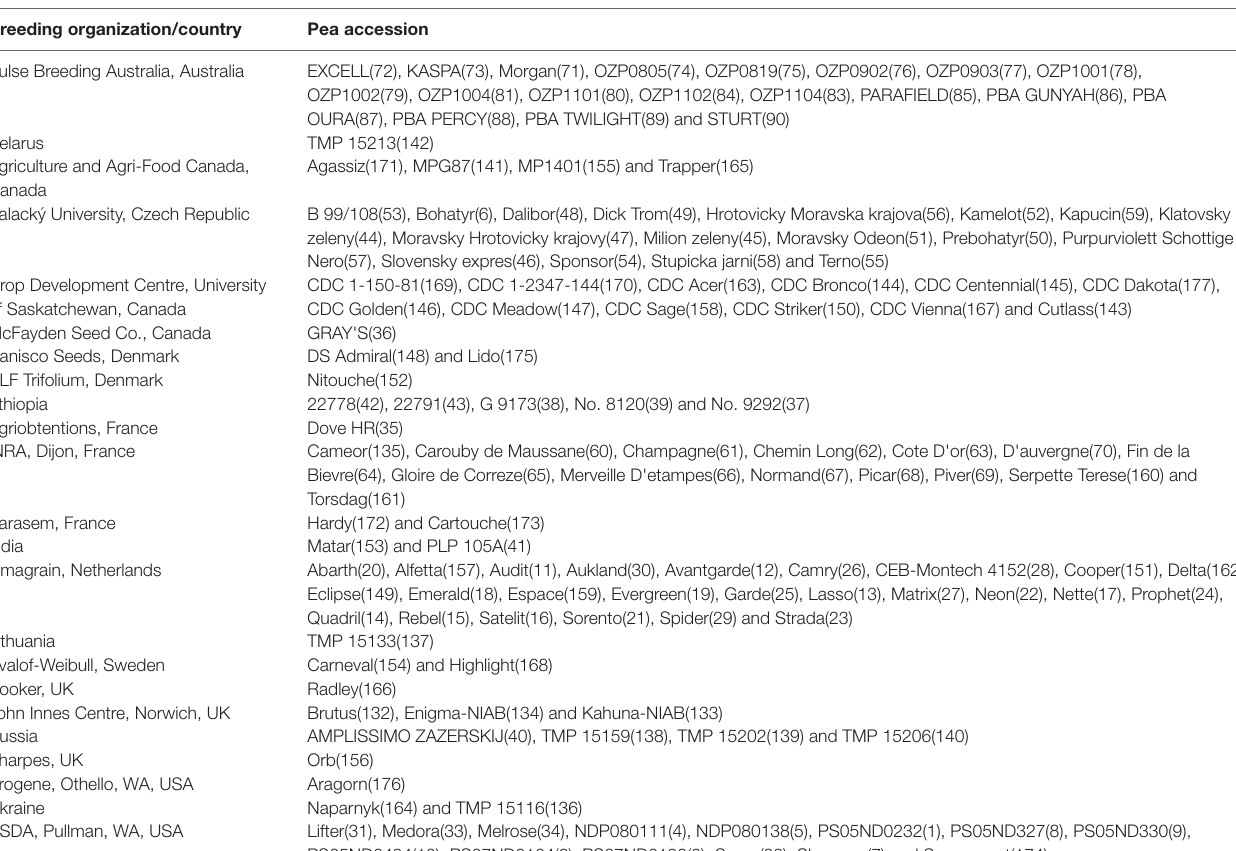
TABLe 1 | List of pea accessions used as genome-wide association study